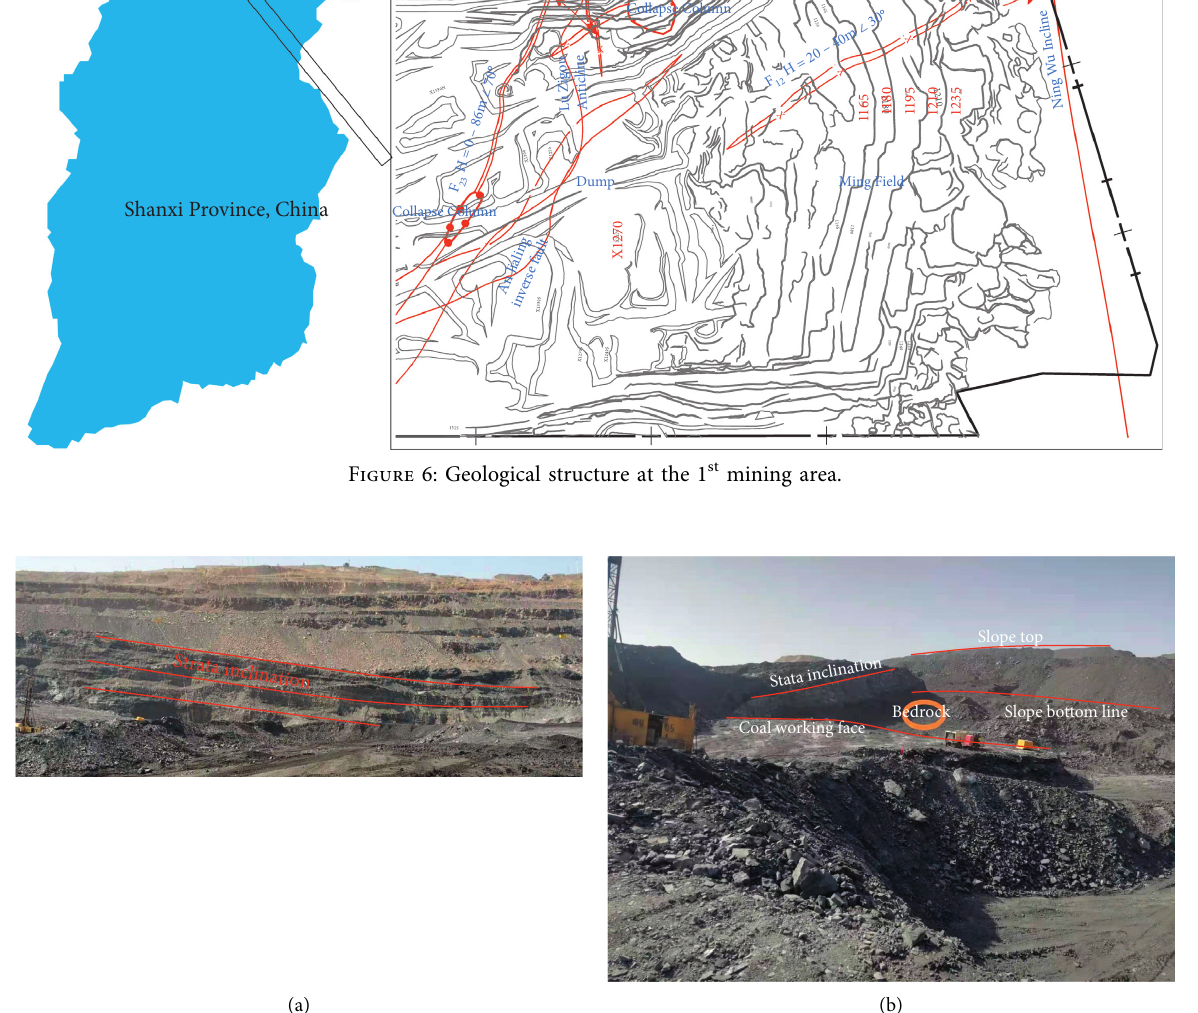
Figure 7: Spatial distribution of Lu Zigou anticline. (a) Inclination of rock. (b) Mining field and